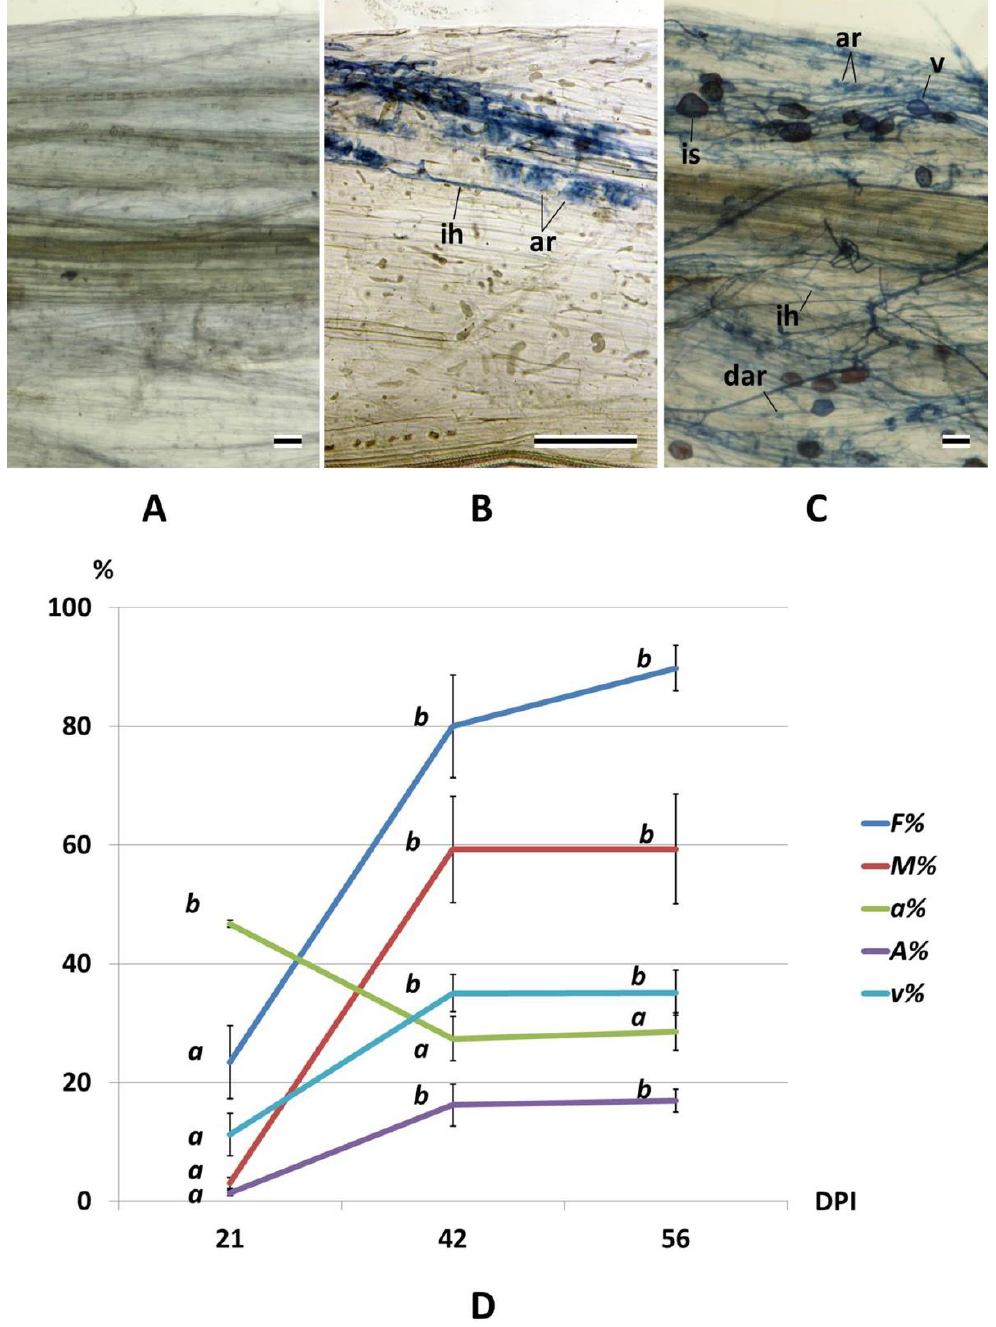
Figure 1. Arbuscular mycorrhiza (AM) development by R. irregularis in cleared pea cv. Finale secondary roots stained with Sheaffer Black Ink. ( A ) Root fragment of a non-inoculated plant. ( B , C ) Intraradical mycelium patterns most characteristic of various stages of AM development. ( B ) The stage of intensive functioning of arbuscules and the exchange of metabolites between the fungus and the plant (most typical for the time point 21 DPI in this experiment). ( C ) The stage of formation of storage and reproductive organs (vesicles and spores) (most typical for the time point 42 and 56 DPI in this experiment). ih , intercellular hypha; ar , arbuscule; dar , degrading arbuscule; v , vesicle; and is , intraradical spore. Scale bar, 50 µ m. ( D ) Quantitative characteristics of AM development in the inoculated plants: F% is the frequency of mycorrhizal colonization, M% is the intensity of intraradical mycelium development, a% is the arbuscule abundance in mycorrhizal root fragments, A% is the saturation of the root system with arbuscules, and v% is the vesicle and spore abundance in mycorrhizal root fragments. The values for each parameter, which are not significantly different from each other ( p ≤ 0.05), are marked with the same letter. Error bars represent standard errors.